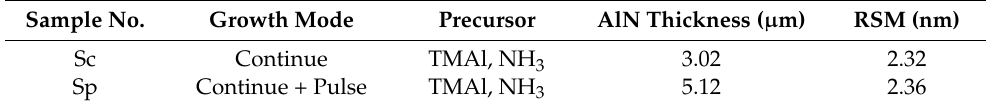
Table 1. Summary of the key aspects for AlN samples. Sample